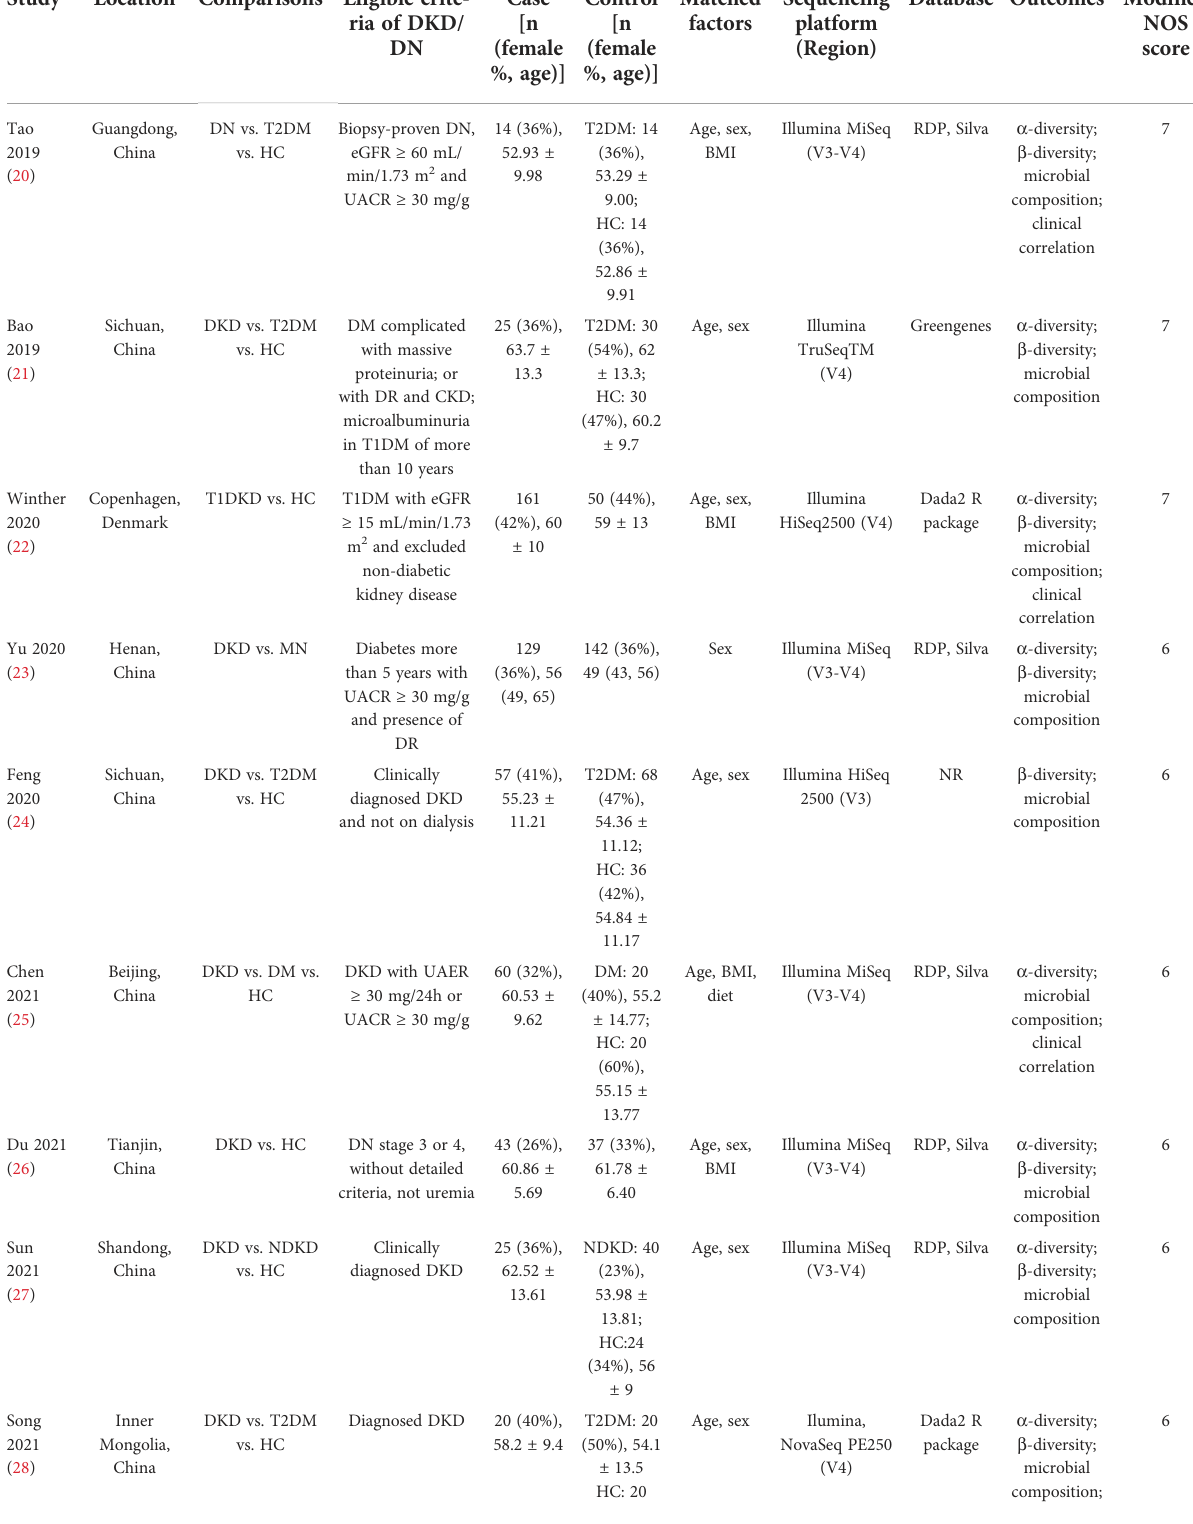
TABLE 2 Characteristics of the included